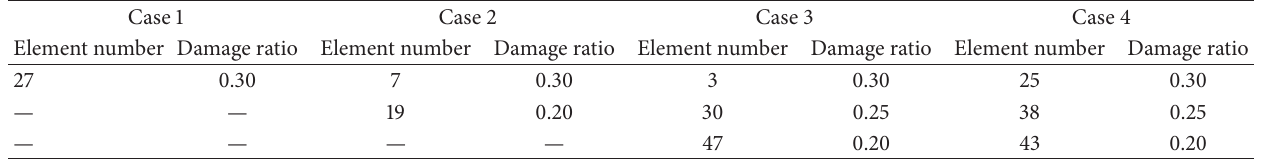
Table 2: Four different damage cases induced in 47-bar planar power line